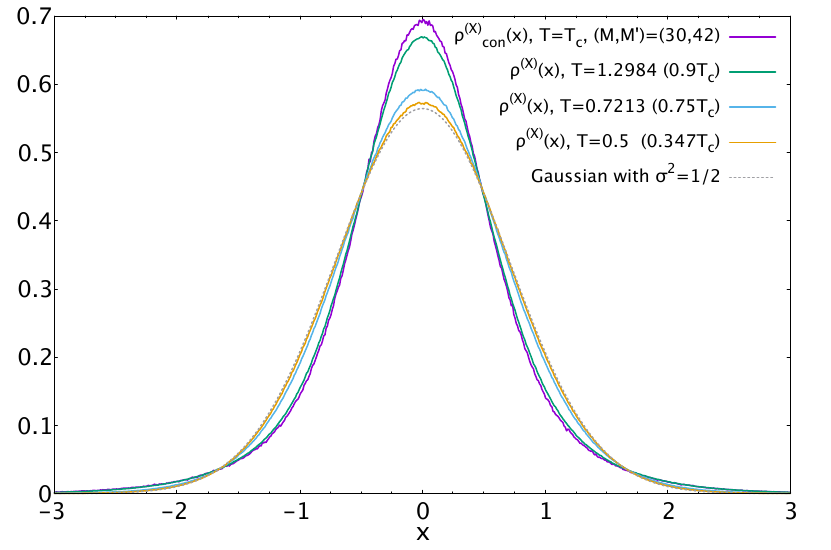
Figure 7. Gaussian matrix model, ρ (X) ( x ) at low temperature, d = 2 , N = 48 , L = 16 . It approaches a Gaussian distribution as the temperature goes